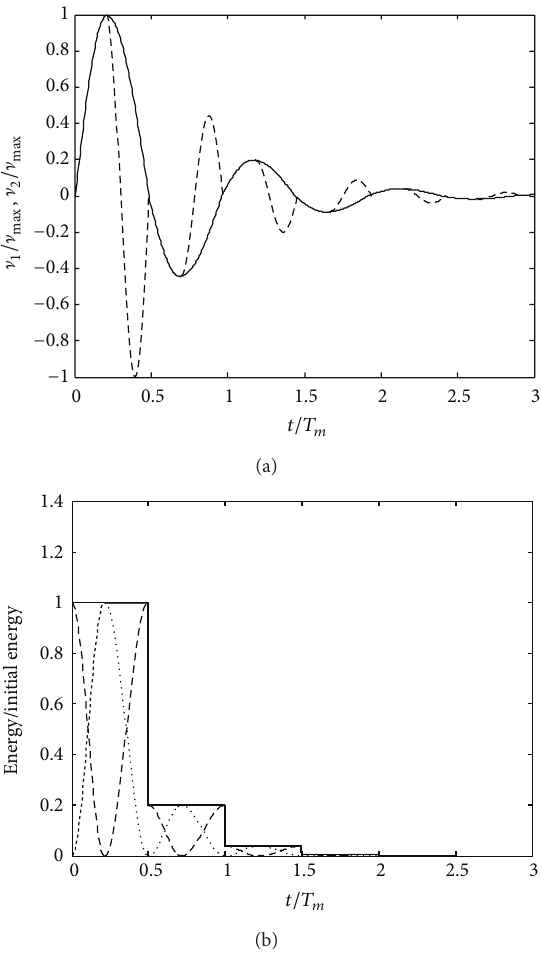
Figure 9: (a) Displacement response for both the main (—) and the secondary system ( - - - ). (b) Energy levels in the system (— total energy; --- kineticenergy; ⋅ ⋅ ⋅ potentialenergy).Timeisnormalised with respect to the mean period 𝑇 𝑚 . For this example the stiffness reduction ratio is 𝜎 = 0.5 and the mass ratio 𝜇 = 0.1 , giving a secondary to primary system frequency ratio Ω = 3